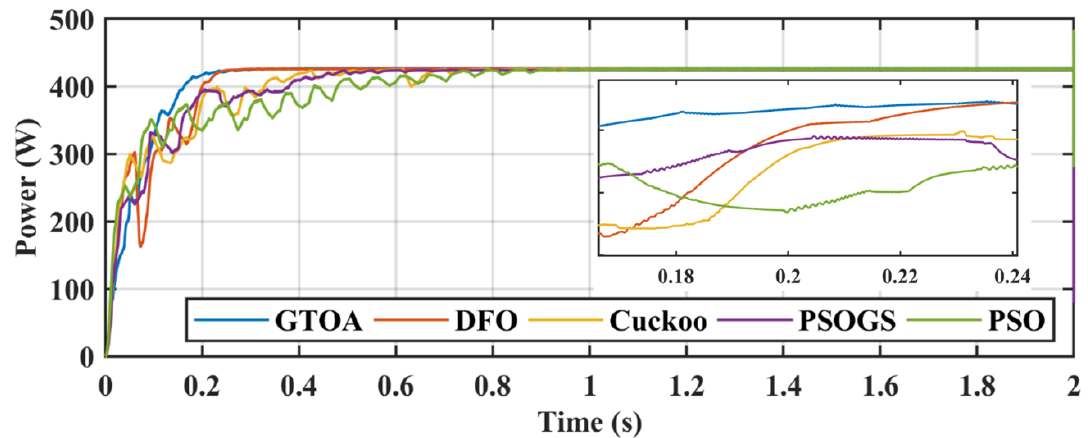
Figure 16. Zoomed-in comparison of power of GTOA.